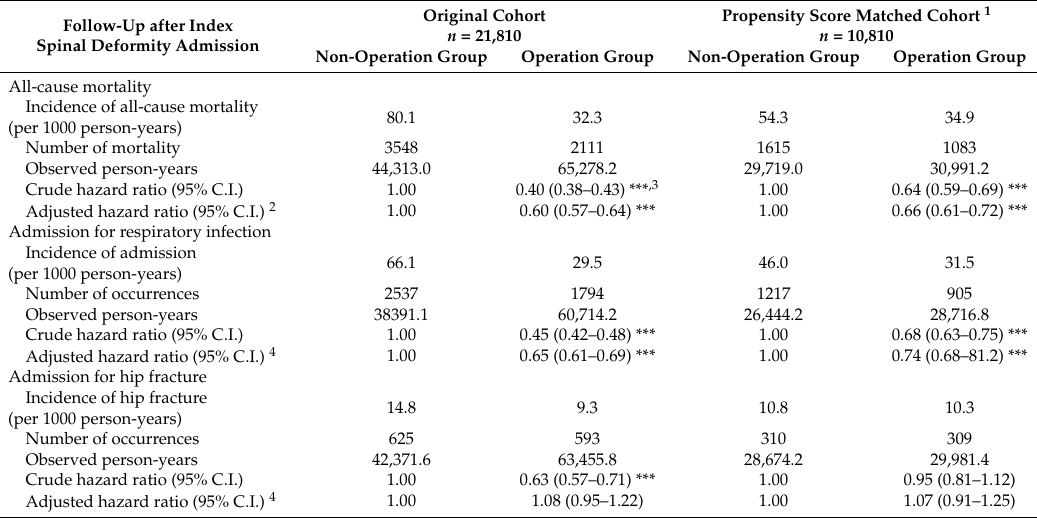
Table 2. Follow-up for all-cause re-admissions, admission for respiratory infection and admission for hip fracture after the index admission for spinal deformity in the original cohort (aged > 50, n = 21,810) and propensity score matched cohort ( n = 10,810) in Taiwan, 2000–2013.